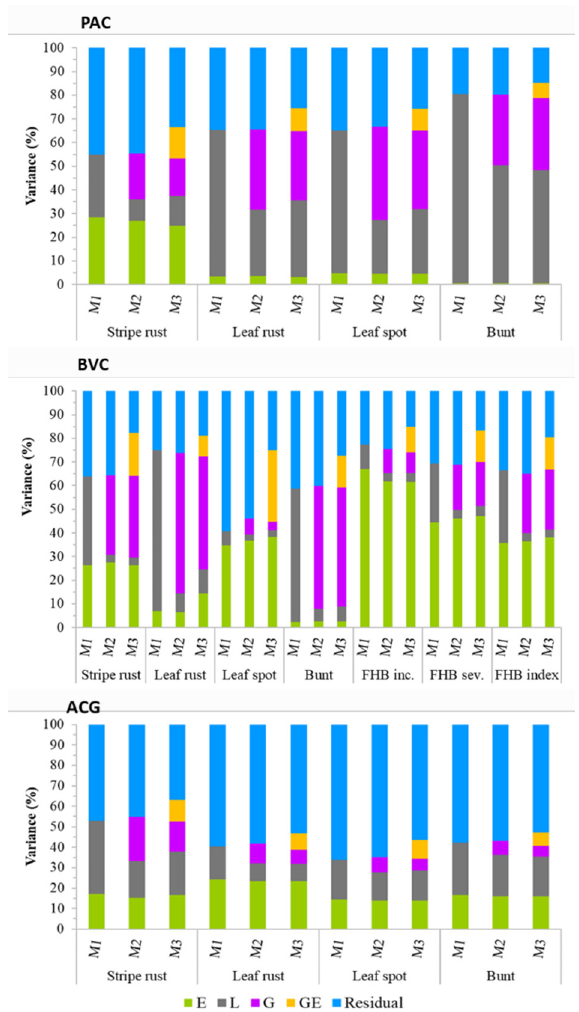
1 BVC: association mapping panel; PAC and ACG: recombinant inbred lines derived from a cross between Peace × Carberry, and Attila × CDC Go, respectively. 2 Within-trait phenotypic correlation coefficients between pairs of environments (site × year combinations). 3 Range: minimum and max- imum scores; Std: standard deviation of the mean.